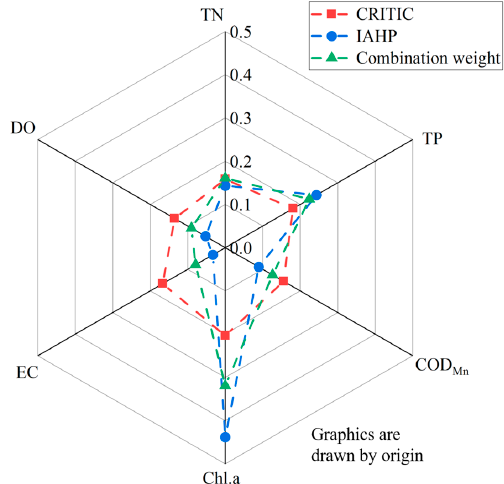
Figure 8. The weight composition of the water quality index of the Maotiao River Basin (Gizhou